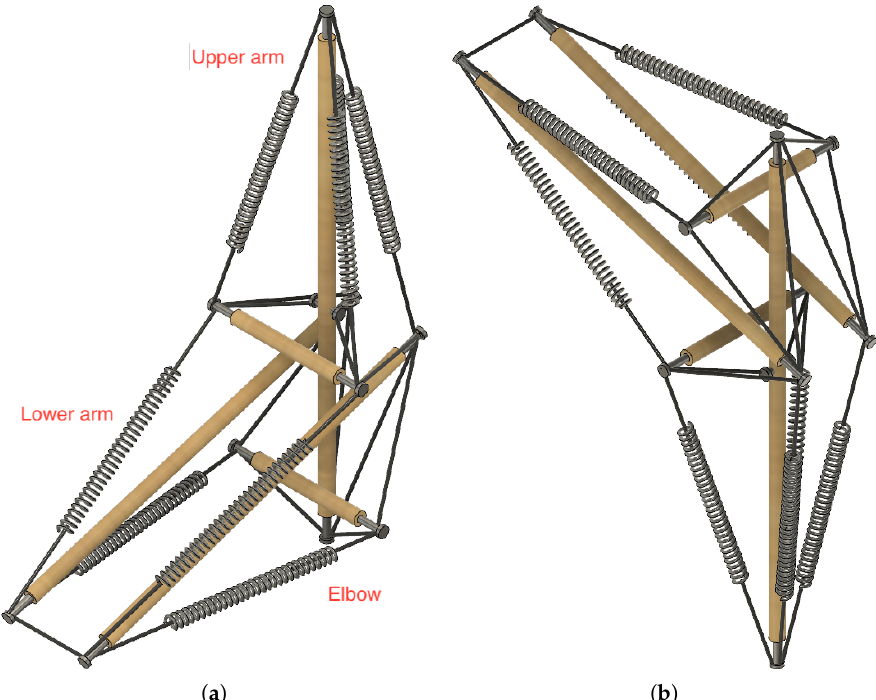
Figure 3. Approximate 3D CAD model of the developed tensegrity arm. Figure ( a ) shows the name of each location. Figure ( b ) shows the model in Figure ( a ) upside down.